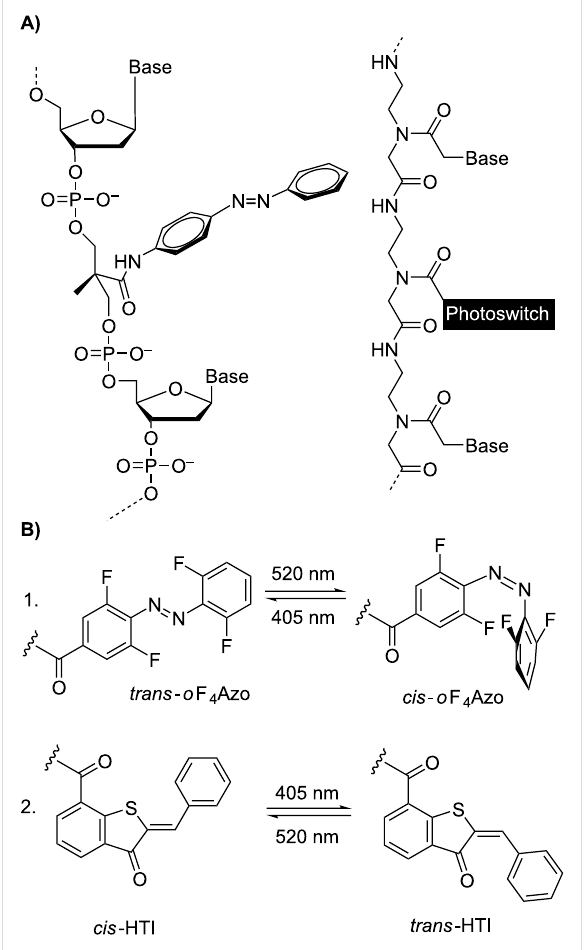
Figure 1: A) Structure of the pioneering azobenzene-modified DNA [16] compared with the photoswitchable PNA structure based on a monomer surrogate. B) Isomerization of the molecular transducers in- corporated and studied in this project: 1.: tetra- ortho -fluoroazobenze ( o F 4 Azo) and 2.: hemithioindigo